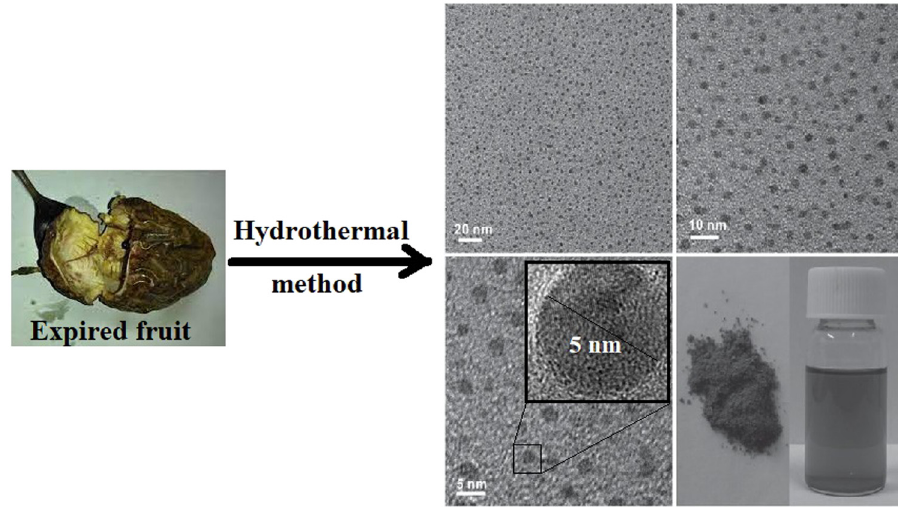
Figure 7: Proposed synthesis technique for powder CQDs by the hydrothermal method and corresponding transmission electron microscopy ( TEM ) images at di ff erent magni fi cations. Copyright © 2021, Springer Publishing Group [ 399 ]